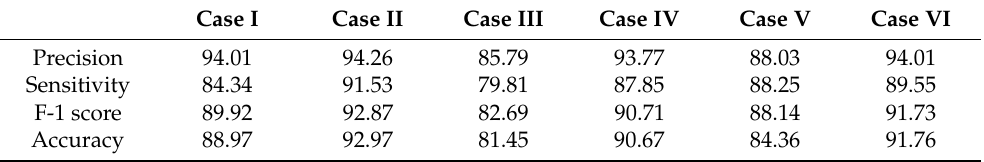
Table 4. Precision, sensitivity, F-1 score, and accuracy evaluation for the various presented